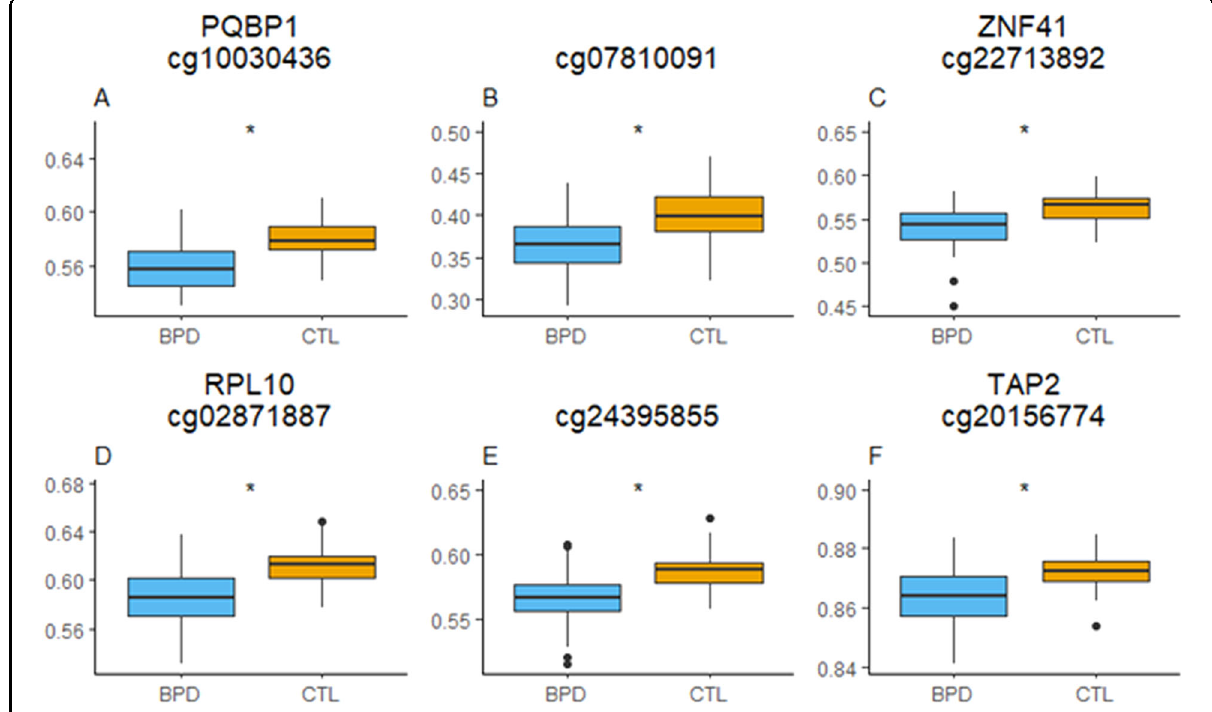
Fig. 1 Signi fi cantly differentially methylated CpG sites resulting from the comparison between BPD ( N = 96) and CTL ( N = 44). Y -axis represents methylation levels ( B values after combat and champ.refbase adjustment, 0 = not methylated, 1 = fully